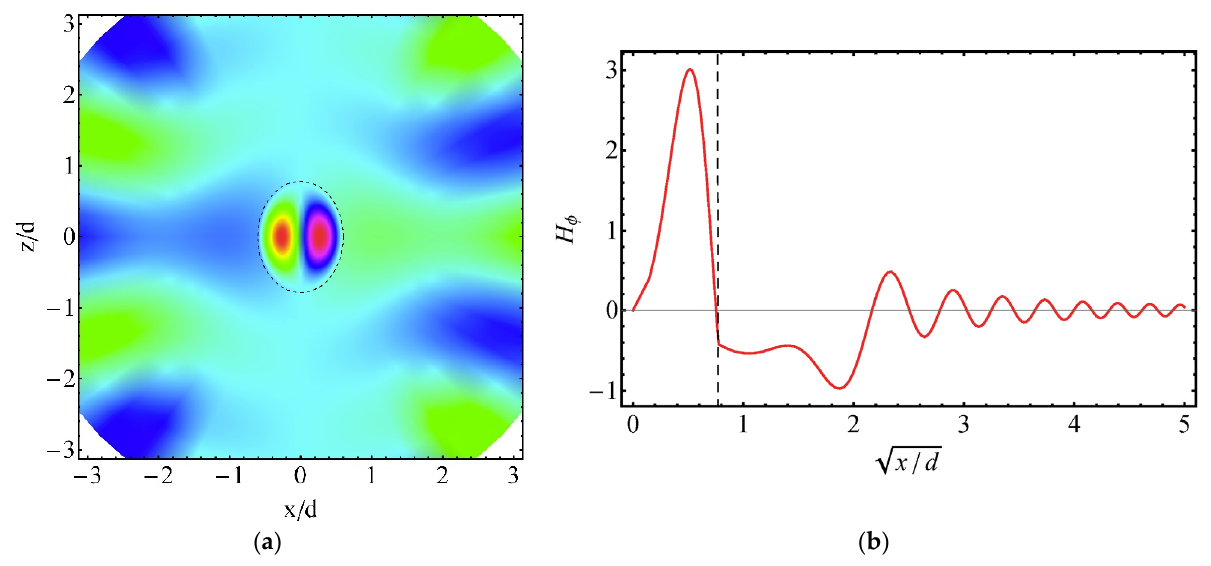
Figure 8. ( a ) Spatial distribution of H φ ( x,z ) and ( b ) the dependence of H φ ( x,z = 0) on x (right) in the PTM 101 mode in a prolate spheroid with ε = 10, k 0 R = 1.57757, k 0 d = 2.4, a/b = 1.3.